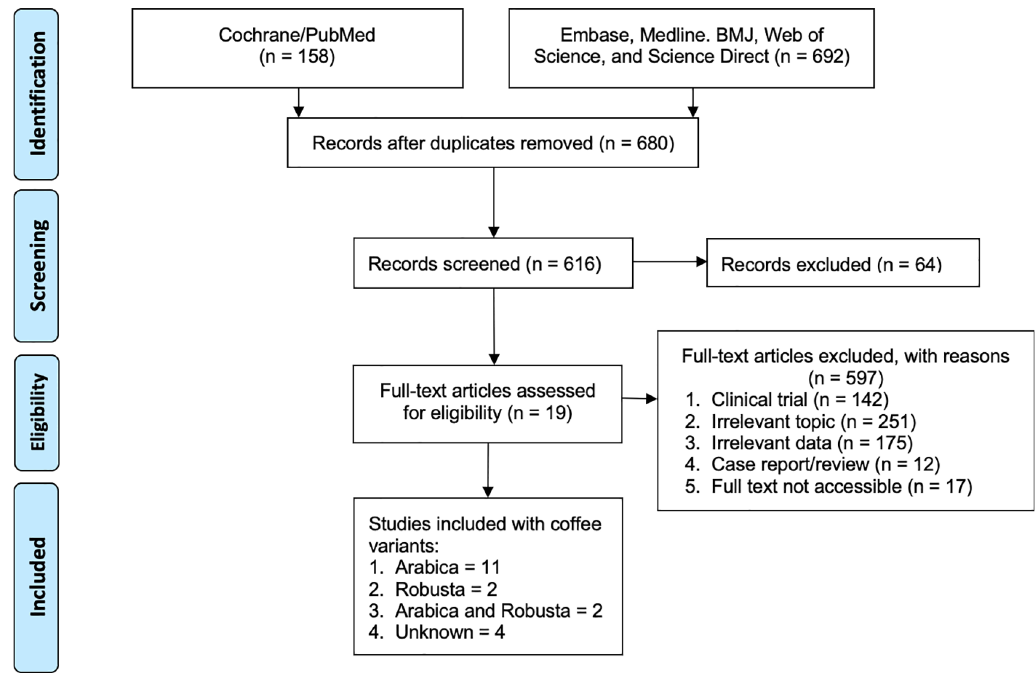
Figure 1. Schematic diagram of the literature search according to